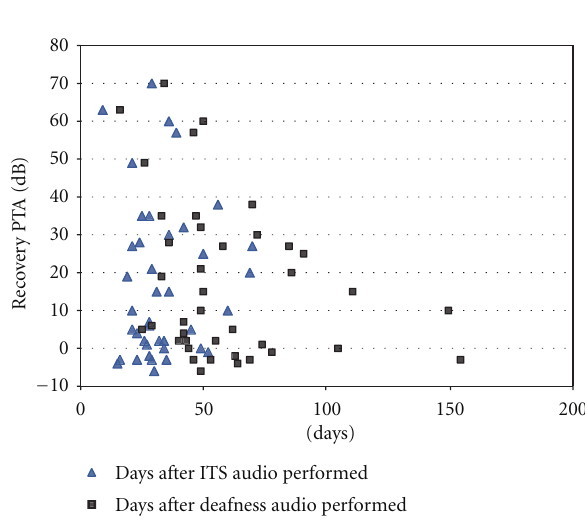
Figure 1: Scatterplot: time from deafness and time from intratym- panic steroids (ITSs) to audiogram; hearing recovery in decibels (dBs).